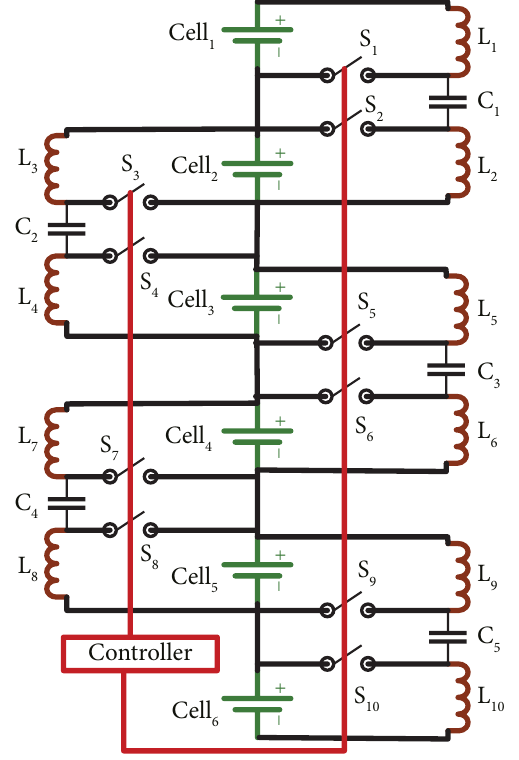
Figure 7: Cuk converter-based